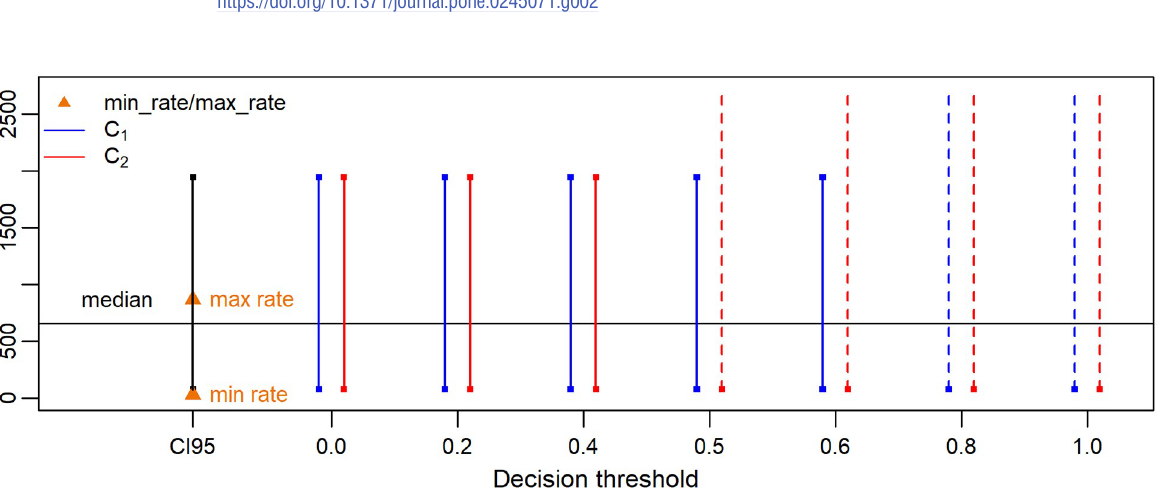
Fig 2. Example of a dose-response curve (A), posterior predictive check (B), prior and posterior distributions of parameters (C) and correlations between parameters (D).